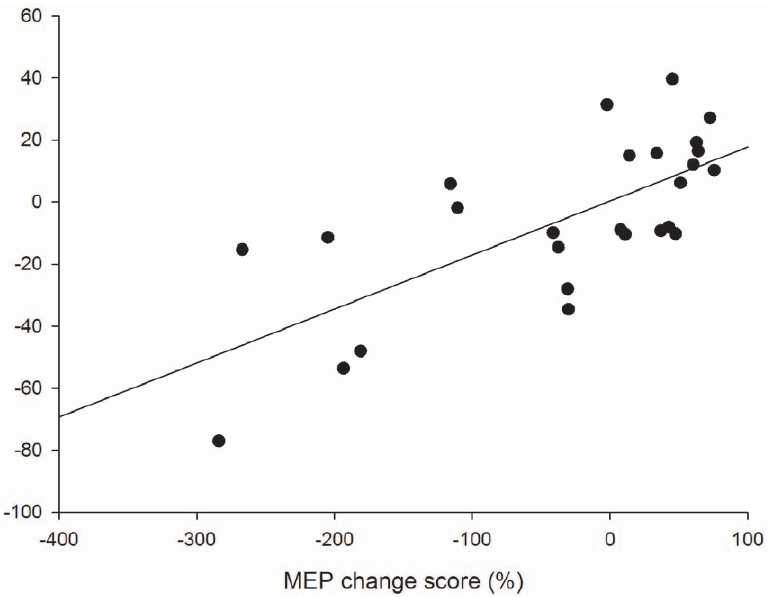
Figure 4. Linear regression between cortical SEP components (N 20 -P 25 and P 25 -N 33 ) and corticomotor excitability (MEP amplitude). Note the significant positive correlation (r=0.71, p , 0.001) between these